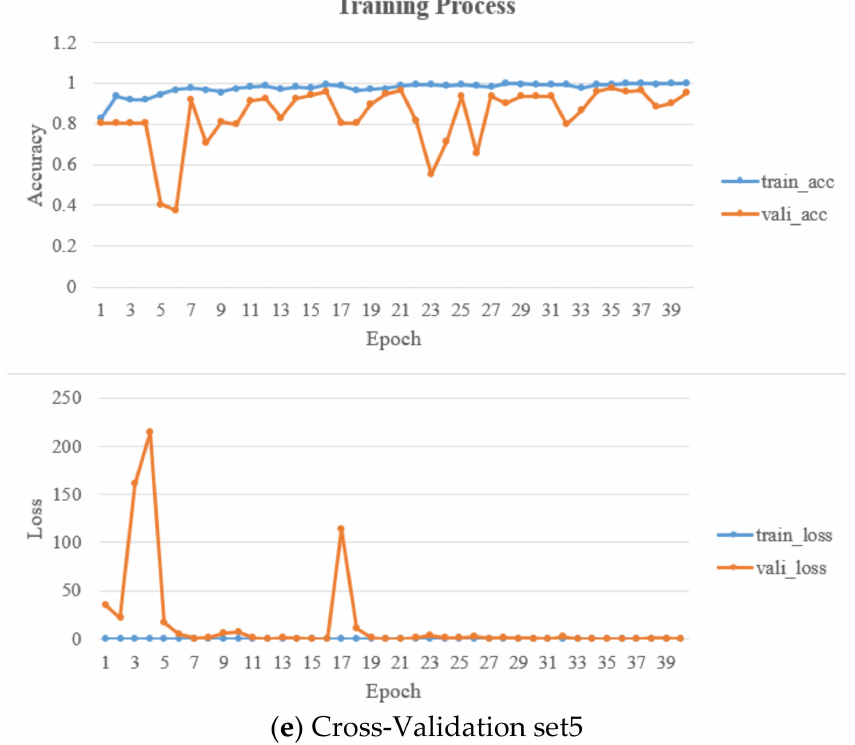
Figure 6. Training process. The accuracy and loss history of the best model, training-all densenet121. ( a – e ) represent the effect of each set.